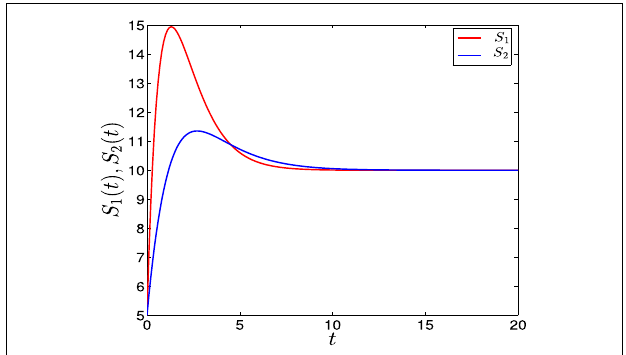
FIGURE 3 |Adaptation form of external signals in GATA1-PU.1 genetic switch .The external signals S 1 and S 2 have different rising times but equal steady states at v = 10. Note that at the end of the signaling the system is structurally